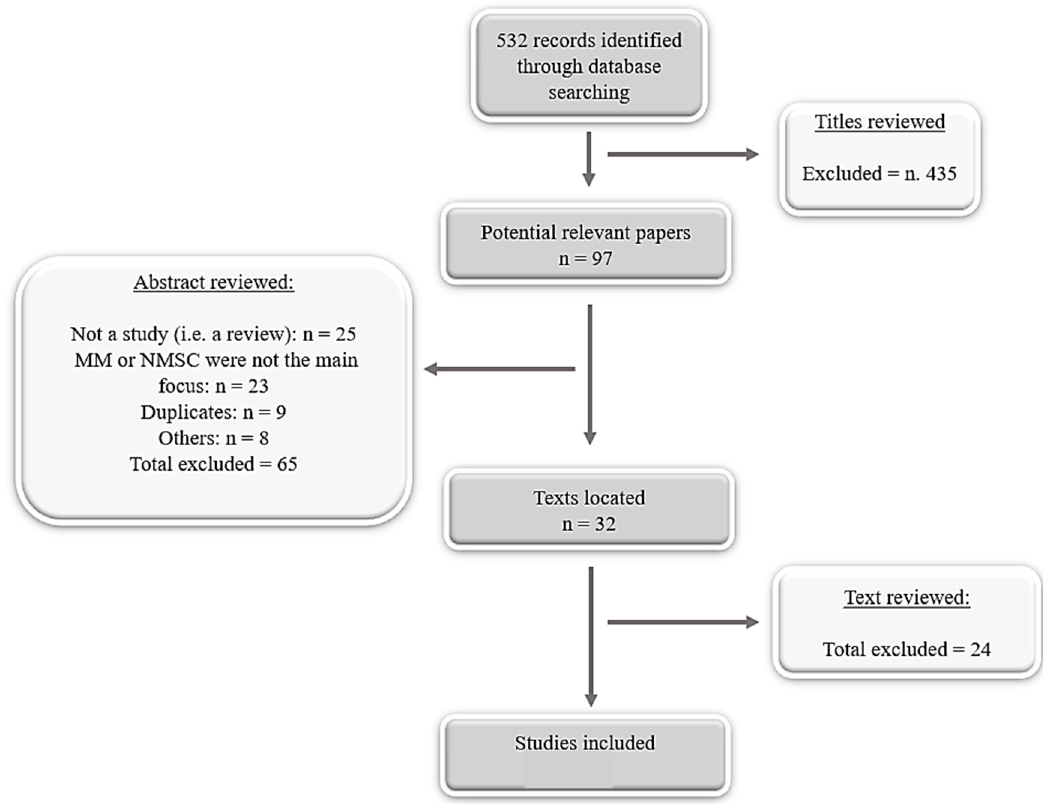
Figure 1. Study flow diagram.